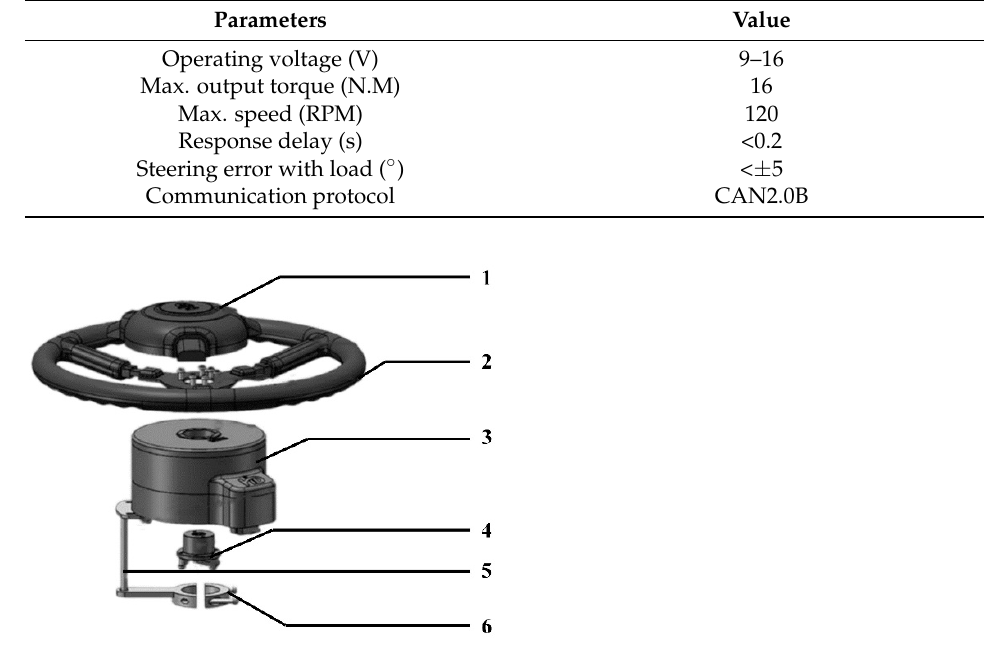
Figure 7. Electric steering wheel installation schematic (1) Steering wheel top cover (2) Steering wheel skeleton (3) Motor (4) Adaptability flange (5) Motor bracket (6) Socket head cap screw.